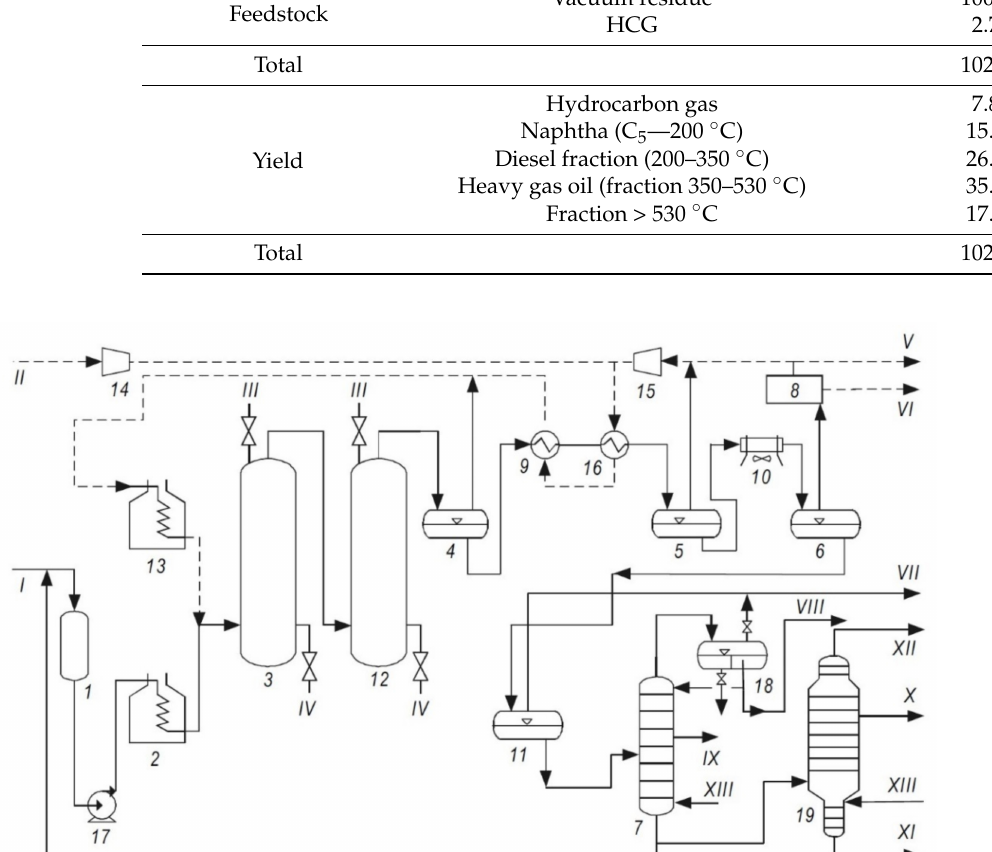
Figure 3. Functional flow diagram of catalytic three-phase fluidized-bed hydrocracking of residual stock. 1, 18—tanks; 2, 13—furnaces; 3, 12—reactors; 4–6, 11—separators; 7—fractional column; 8—hydrogen sulfide treatment unit; 9, 16—heat exchangers; 10—cooler; 14, 15—compressors; 17—pump; 19—vacuum column; I—stock; II—hydrogen; III—fresh